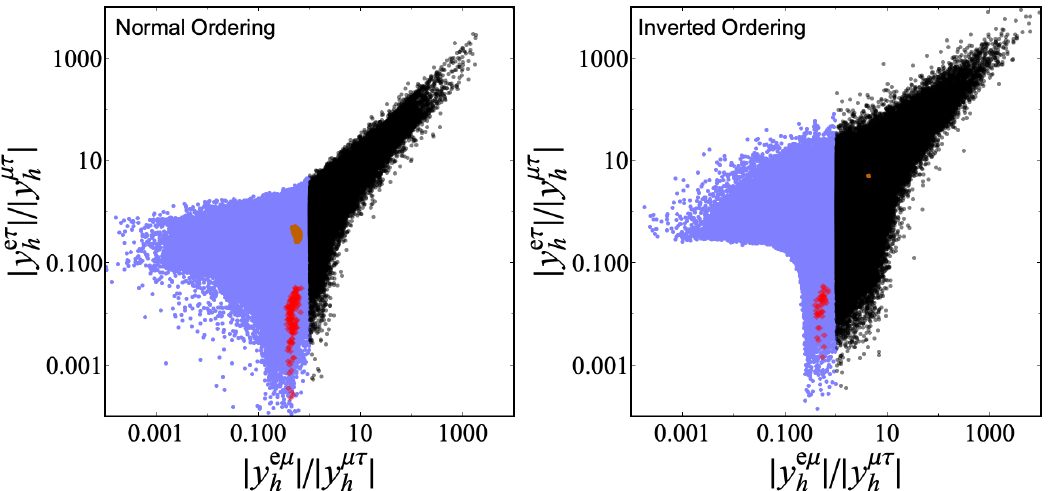
| / | y µτ | and | y eτ | / | y µτ | as obtained in the numerical scan. h h h h